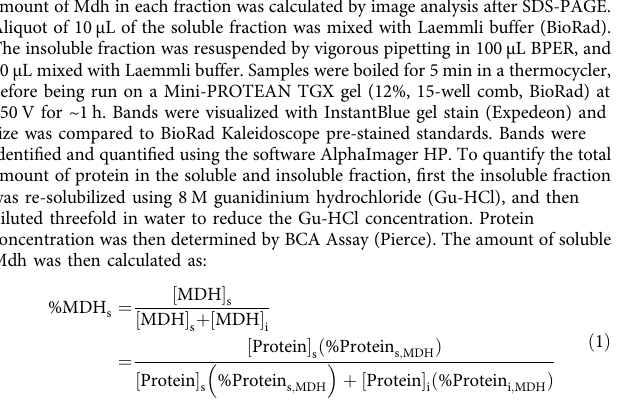
Supplementary Table 4. The point mutation was con fi rmed by sequencing of the PCR-ampli fi ed chromosomal fragment after curing of all cloning plasmids, and transaldolase activity was assessed in crude lysates as described